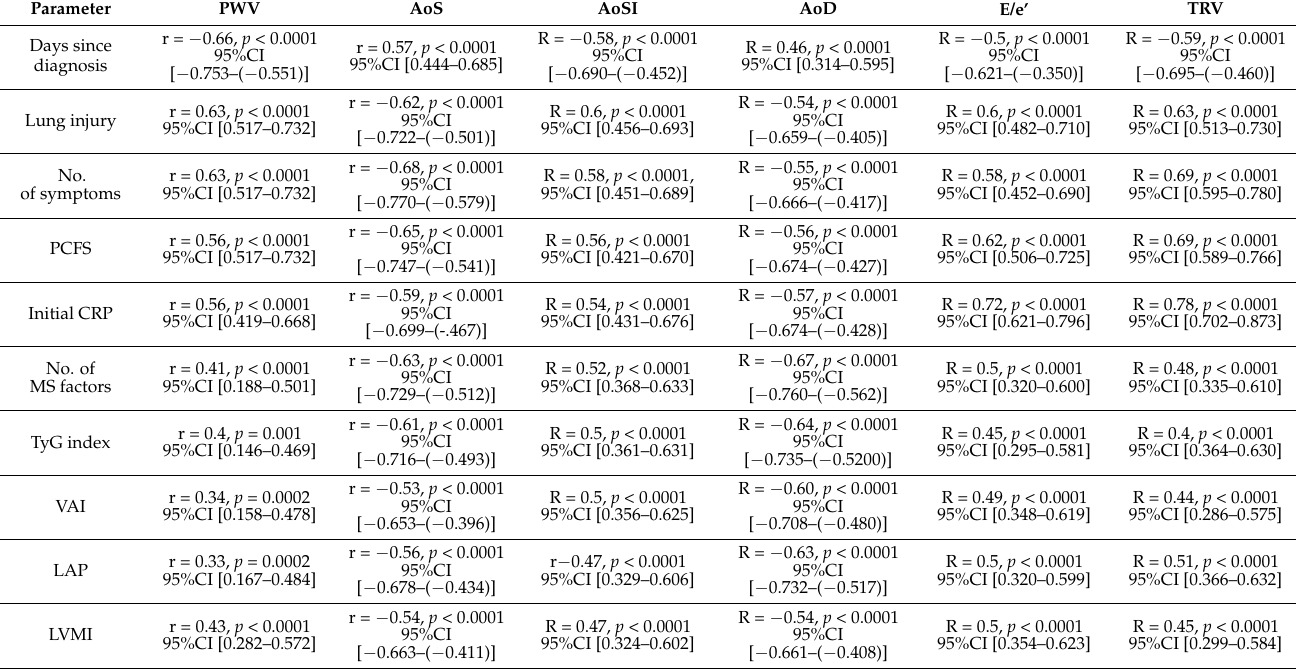
Table 4. Correlation between parameters characterizing arterial and aortic stiffness and DD, and other clinical and laboratory factors in 121 patients (group A =